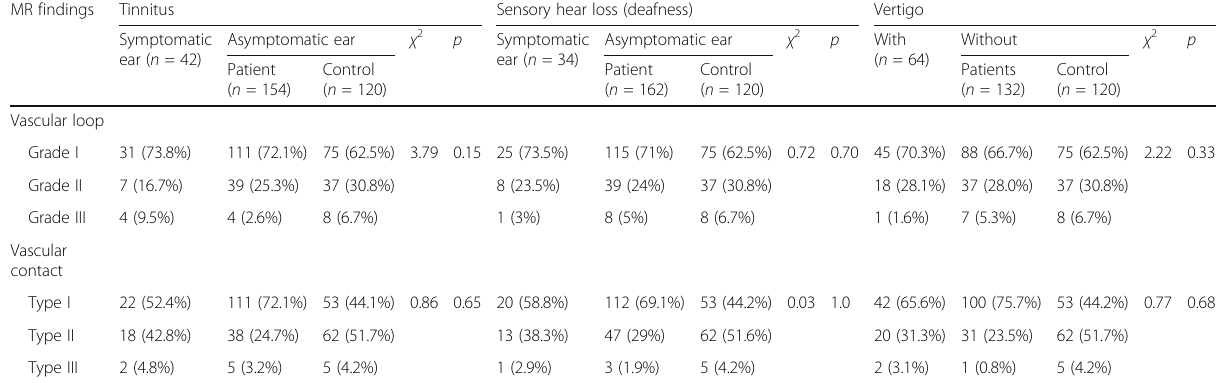
Table 2 Distribution of audio-vestibular dysfunction symptoms in patients with vascular loop/vascular contact MRI MR findings